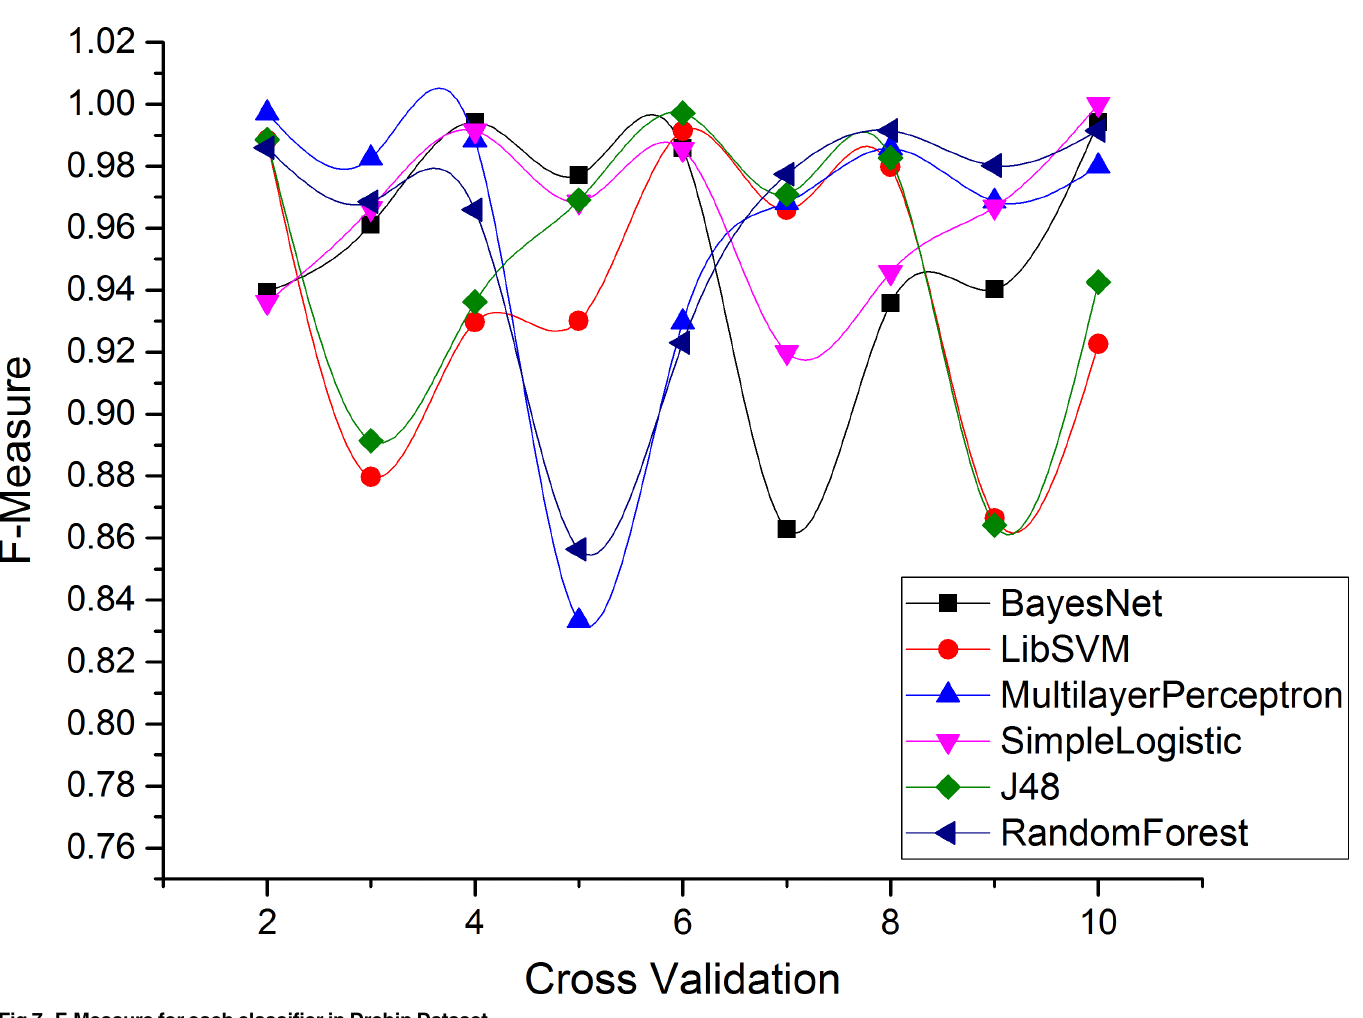
Fig 7. F-Measure for each classifier in Drebin Dataset.